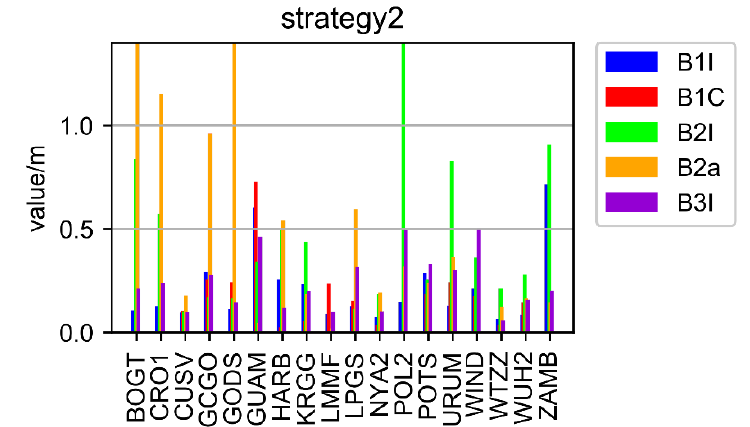
Figure 7. The results of Strategy 1.